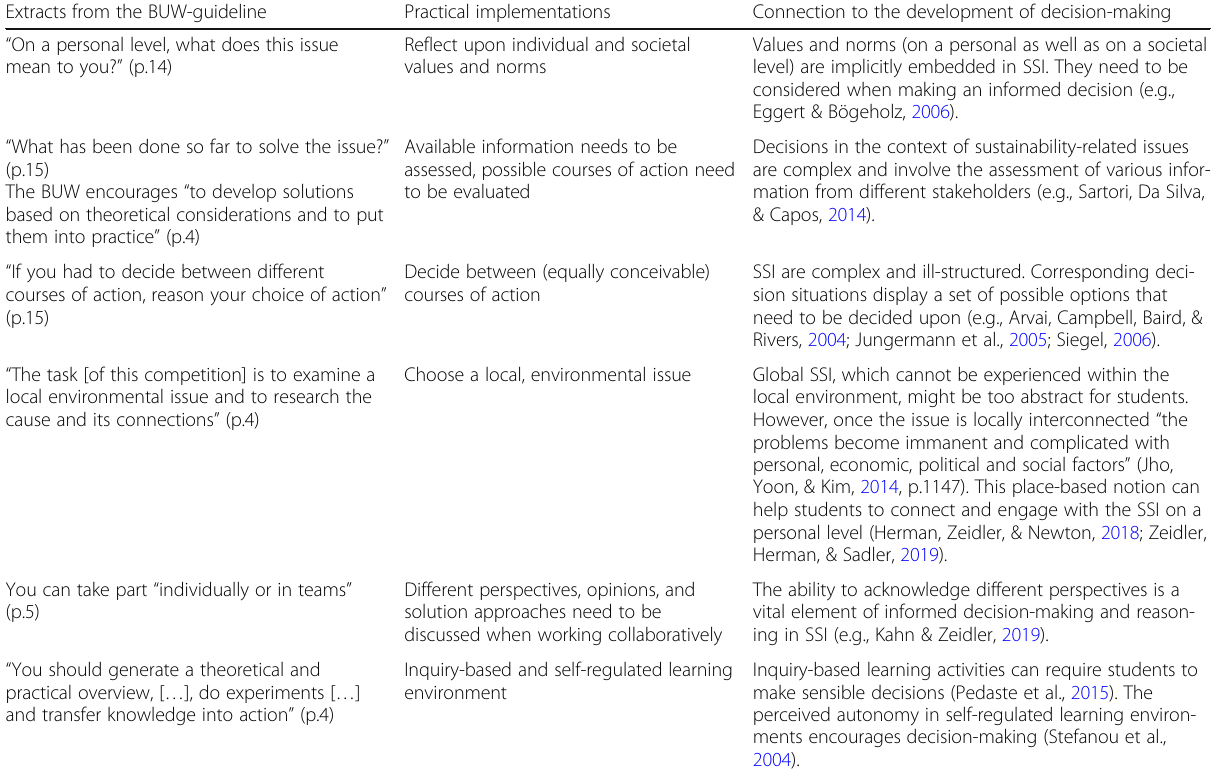
Table 1 Exemplary aspects of the BUW potentially initiating socioscientific decision-making Extracts from the